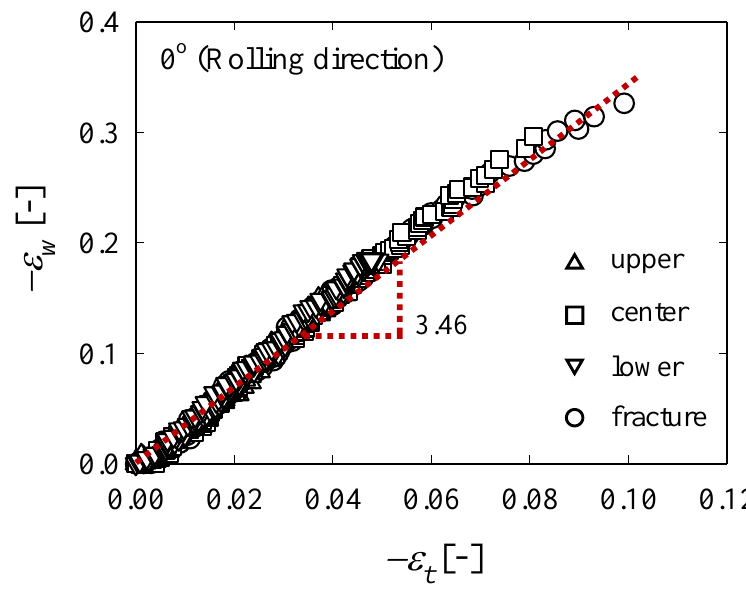
ε ε w and t for various location (RD specimen).